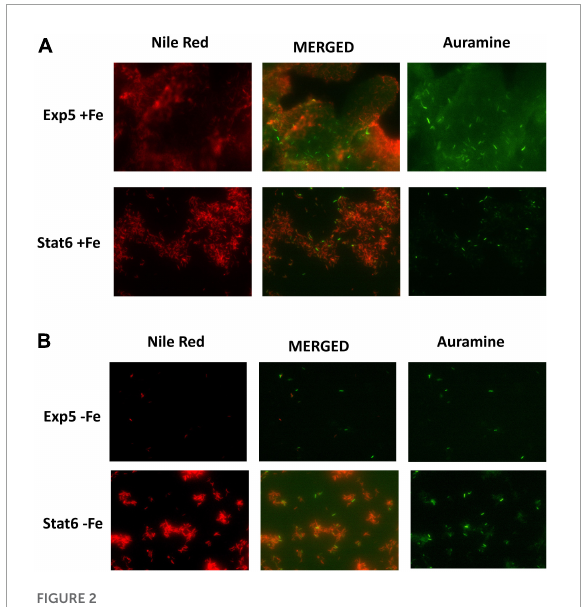
FIGURE2 Double staining Auramine/Nile Red at exponential and stationary culture phases. Same frame of cultures with (A) and without (B) iron at exponential (Exp5–Fe) and stationary (Stat6–Fe) phases of growth stained with Auramine (right) and Nile Red (left). Corresponding merged image is also shown in the central panel.